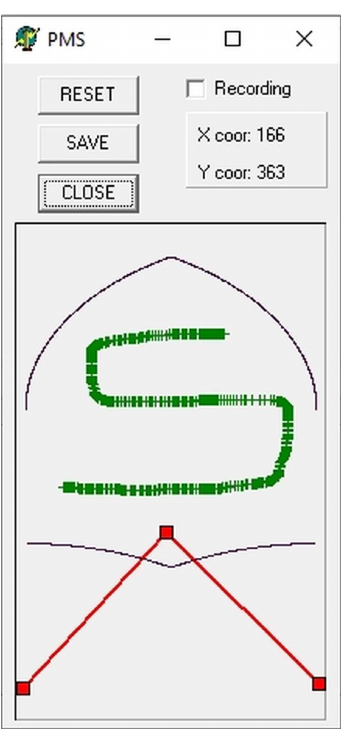
Figure 5. The main window of the PMS